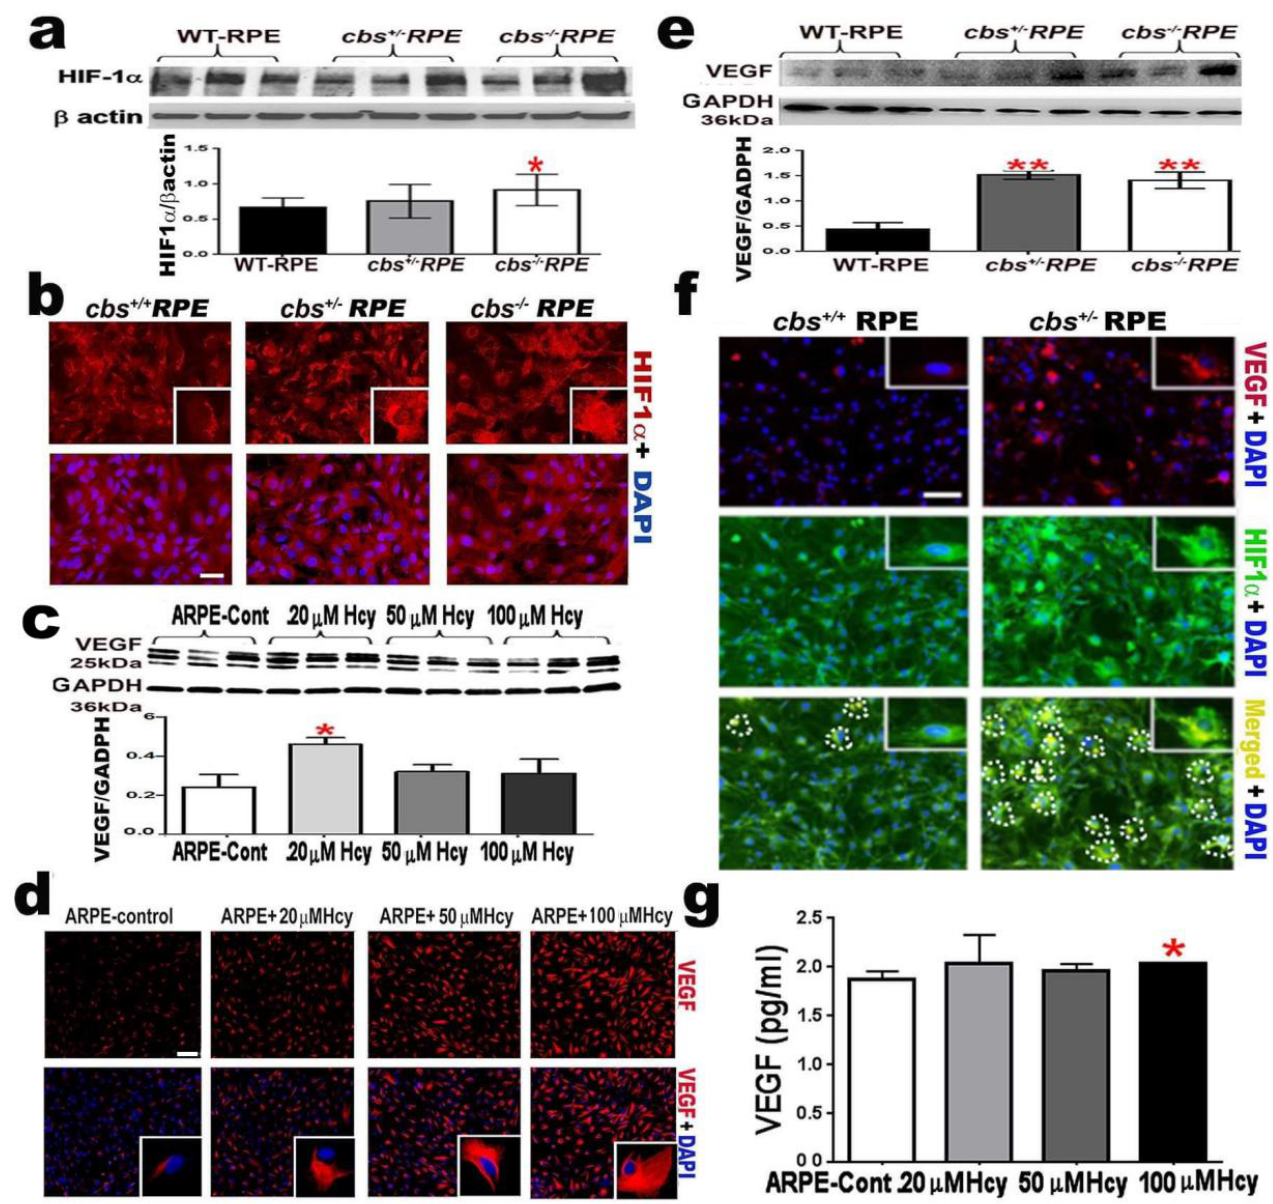
Figure 2. Homocysteine promotes angiogenic factors ( a ) Western blotting of HIF-1 α expression in primary RPE cells isolated from mice model of elevated Hcy (wild-type cbs +/+ , cbs +/ − , and cbs − / − ) showing a significant increase in HIF-1 α